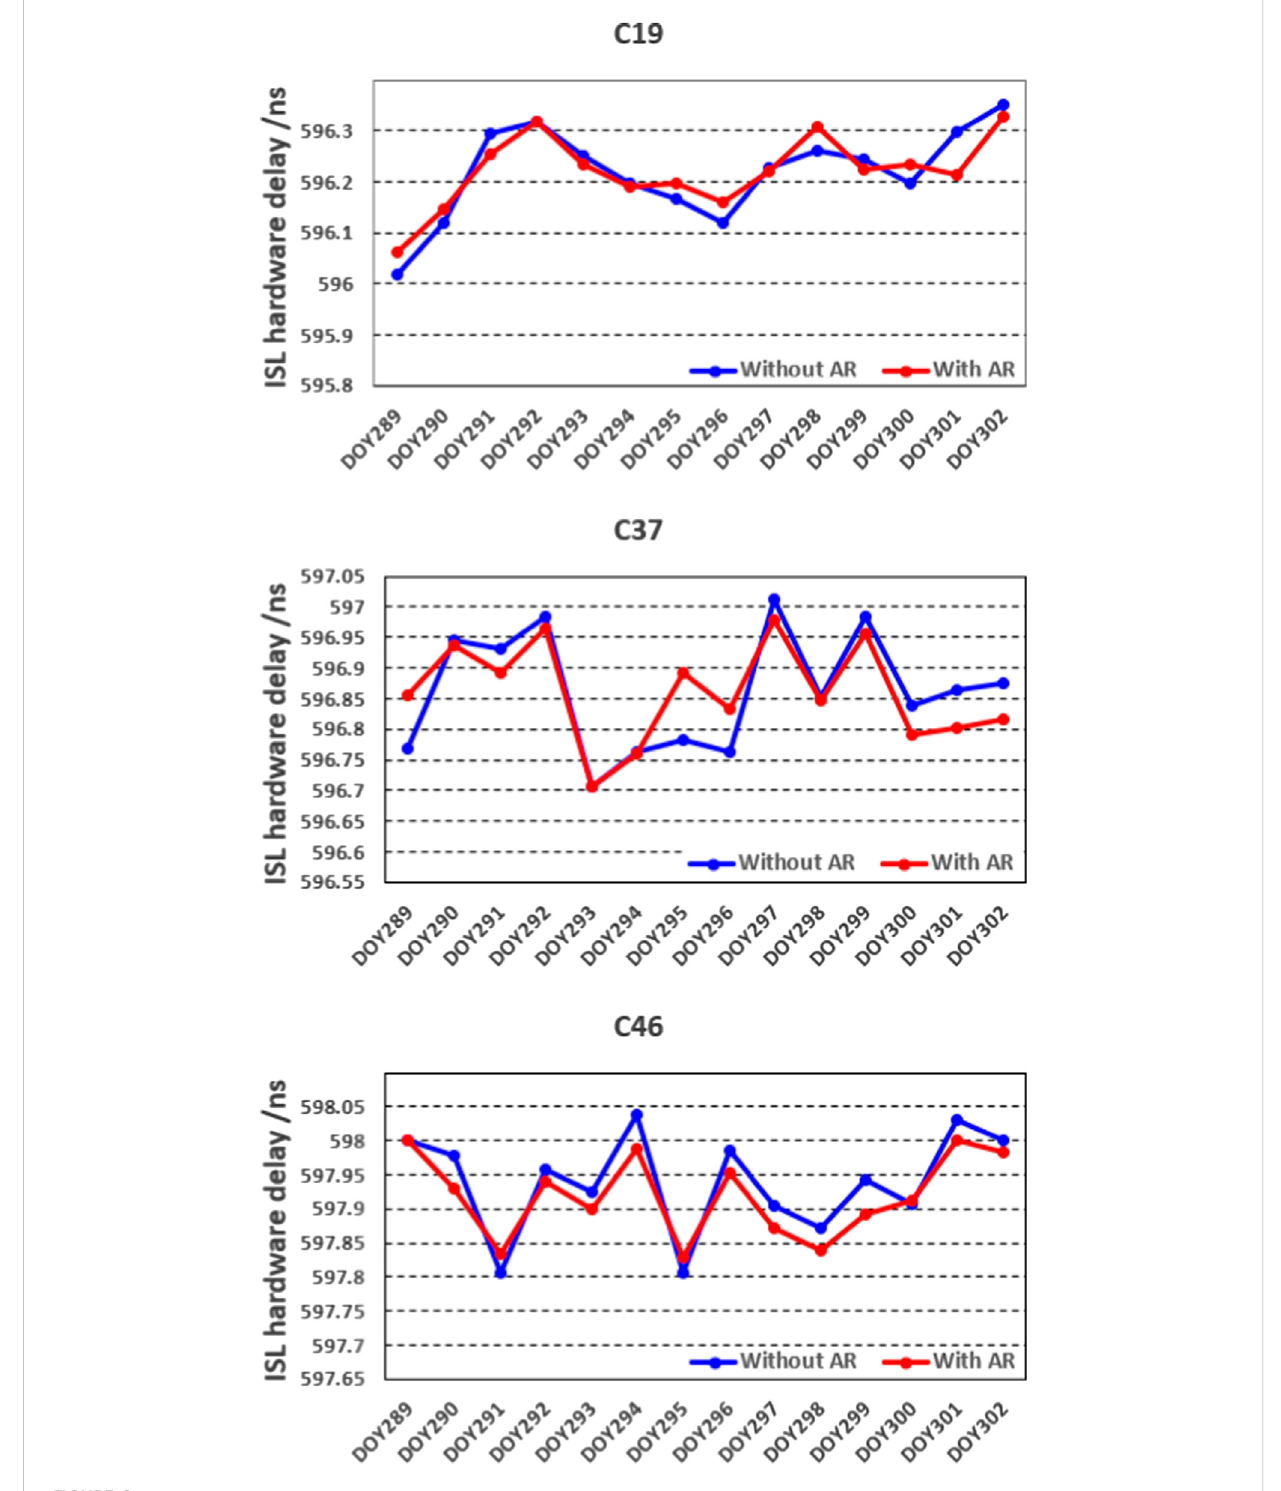
FIGURE 6 Estimated hardware delay in time series during 2 weeks for satellites C19, C37, and C46 as